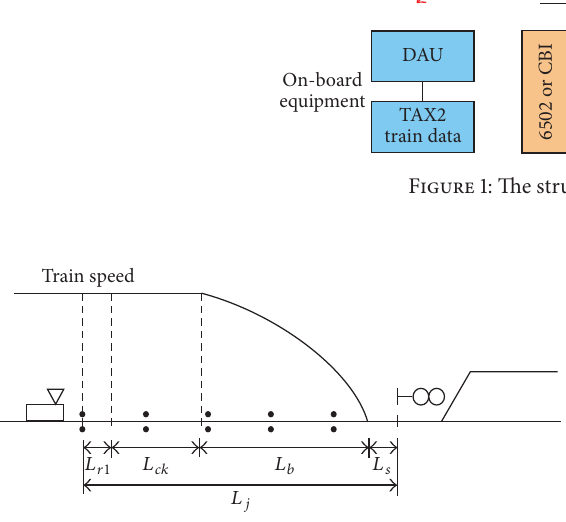
Figure 2: The composition of train route approach locking